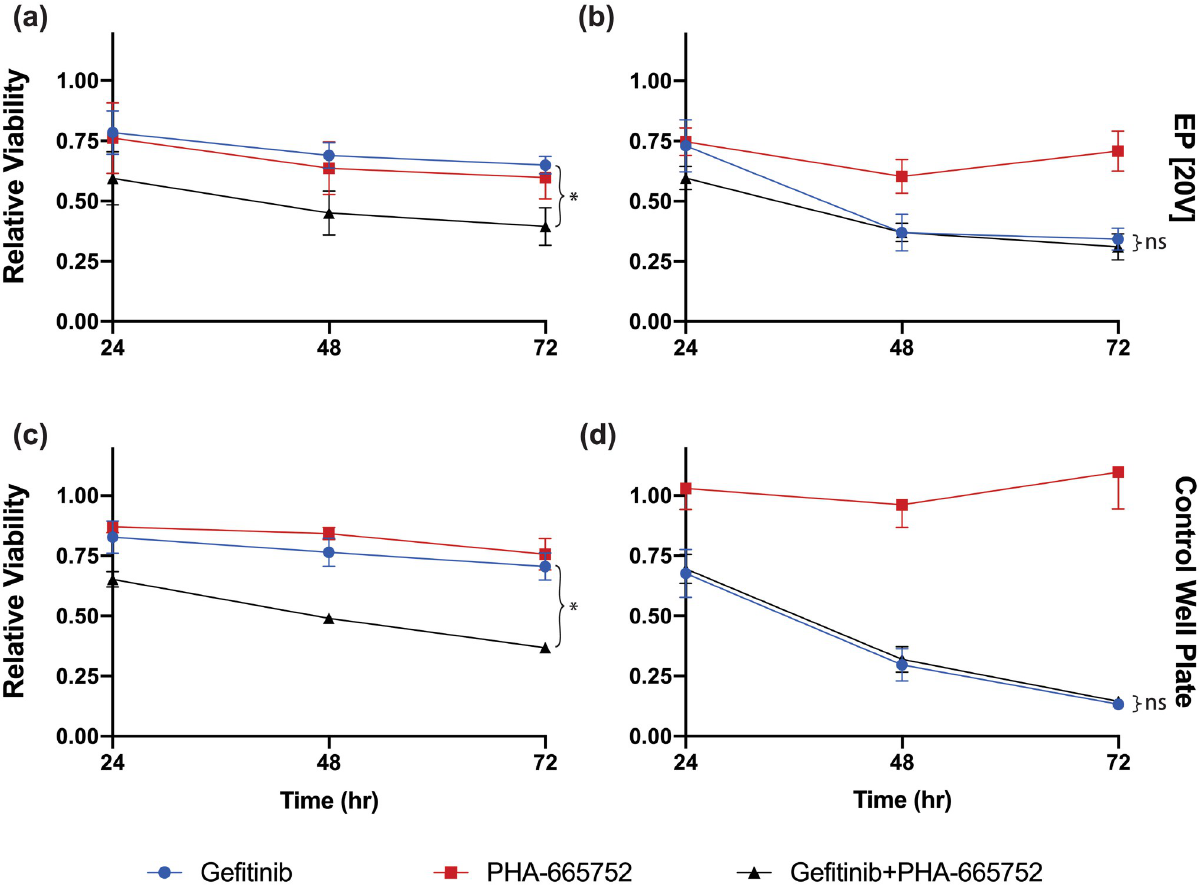
Fig 3. Drug response curves of HCC827 cells to gefitinib and PHA-665752. Viability response of (a) HCC827 GR6 and (b) wt cells after electroporation in gefitinib (100 nM), PHA-665752 (20 nM), or a sequential combination of both at time points 24, 48, and 72 hrs. Control conventional well-plate assays of (c) HCC827 GR6 and (d) wt cells, respectively, containing an identical solute quantity of drugs flown into the device during the electroporation step (100 and 20 pmol for gefitinib and PHA-665752, respectively). Shown viability% is normalized by the luminescence intensity of untreated control cells in their respective condition. Relatively high standard deviations associated with the collected cell counts can be attributed to repeated electroporation of cells on the same device, leading to eventual debris buildup on the electrodes, interfering with consistent cell capture. Error bars represent the standard error of the mean (n = 3). � p < 0.1 vs gefitinib (control)